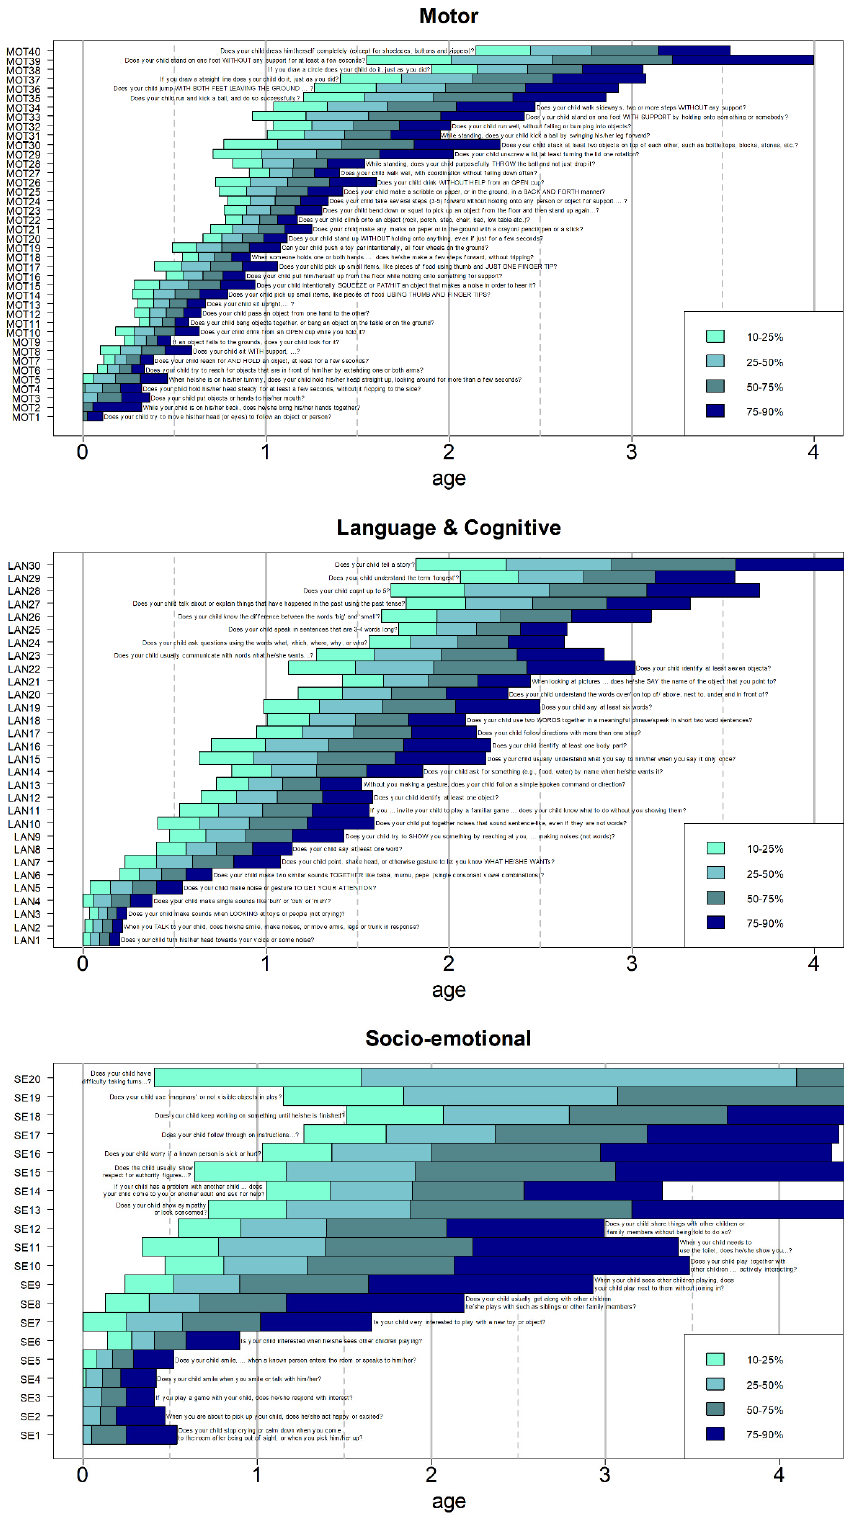
Figure 4. Domains of development with age succession of items with bars showing 10th, 25th, 50th, 75th and 90th centile for attainment across